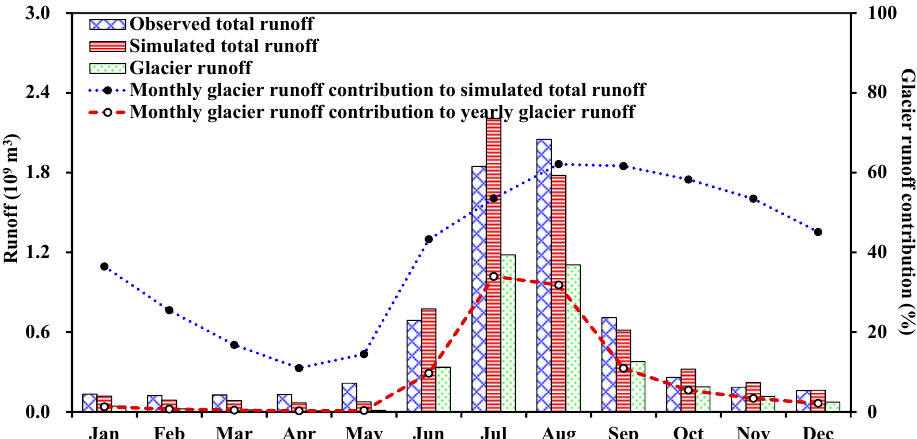
Figure 7. Multi-year monthly average observed and simulated total runoff, glacier runoff as well as its monthly contributions.